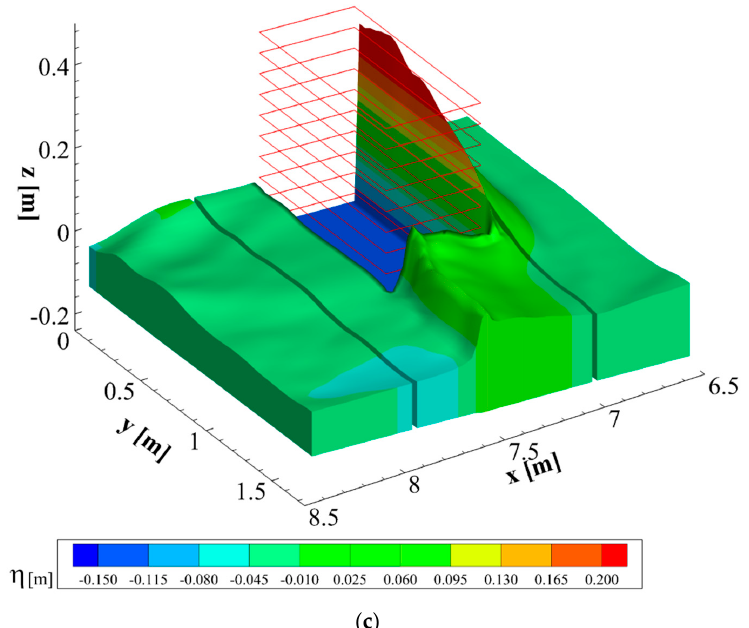
Figure 15. Wave–structure interaction. Instantaneous snapshots of the free surface obtained using the proposed model (the barrier was drawn as transparent for purposes of clarity). Three different instantaneous wave field: ( a ) T = 100 s, ( b ) T = 101 s and ( c ) T = 102